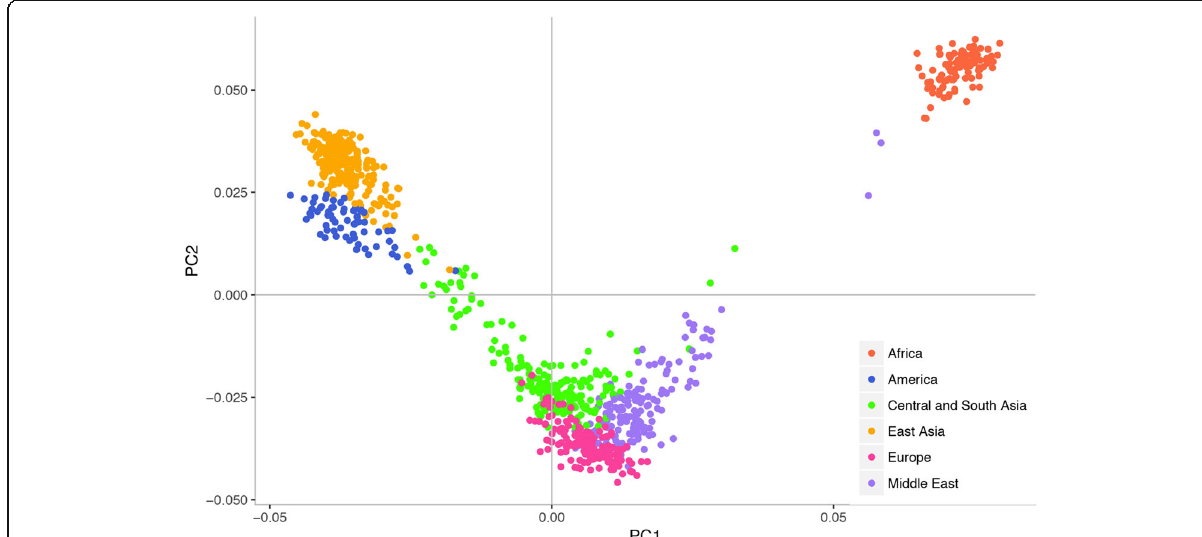
Fig. 1 PCA result. The scatterplot shows the first two components of PCA analysis based on genotype data of SNPs located in genes coding for transporters of cofactors in individuals from HGDP dataset. Each point corresponds to one individual, color-coded according to the geographic region of origin as shown in the legend